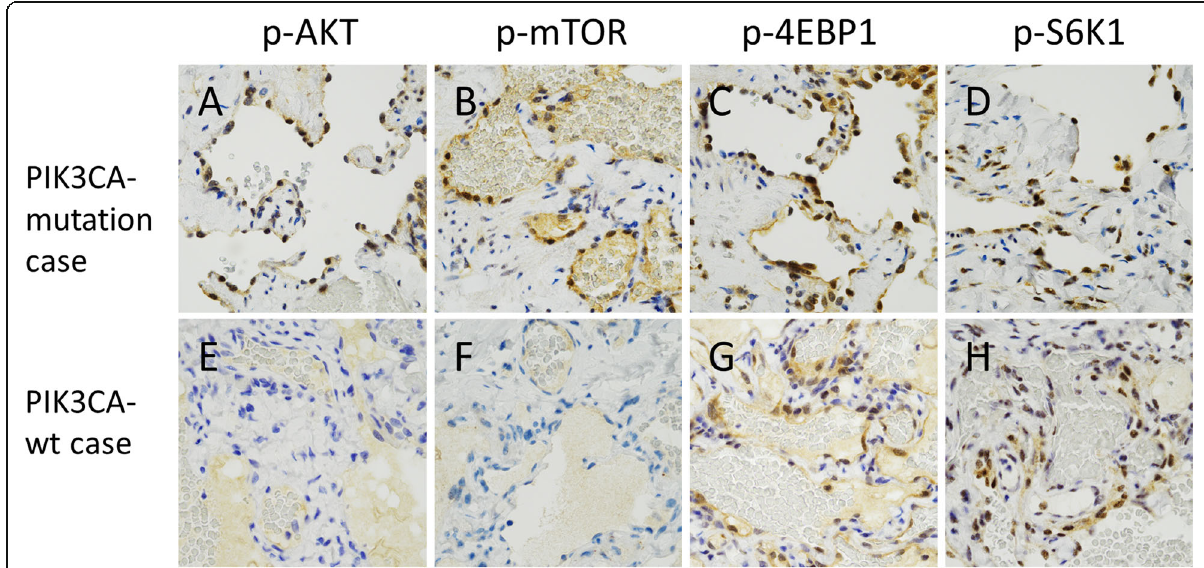
Fig. 3 Immunohistochemical expression of the mTOR pathway in abnormal vessels of FAVA. A-H Representative immunohistochemical staining patterns of abnormal vessels in PIK3CA-mutation case ( A-D ) and PIK3CA-wild type (wt) case ( E-H ). Both cases express phosphorylated eukaryotic translation initiation factor 4E-binding protein 1 (p-4EBP1) and phosphorylated ribosomal protein S6 kinase 1 (p-S6K1), but only the PIK3CA- mutation case expresses phosphorylated AKT (p-AKT) and phosphorylated mammalian target of rapamycin (p-mTOR). The PIK3CA-wt case does not express p-AKT or p-mTOR